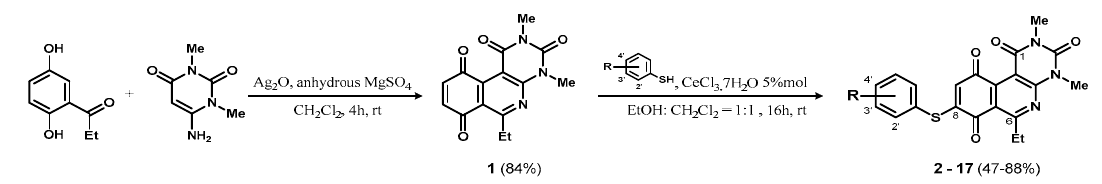
Figure 1. Synthetic route of the preparation of core 1 and compounds 2 – 17